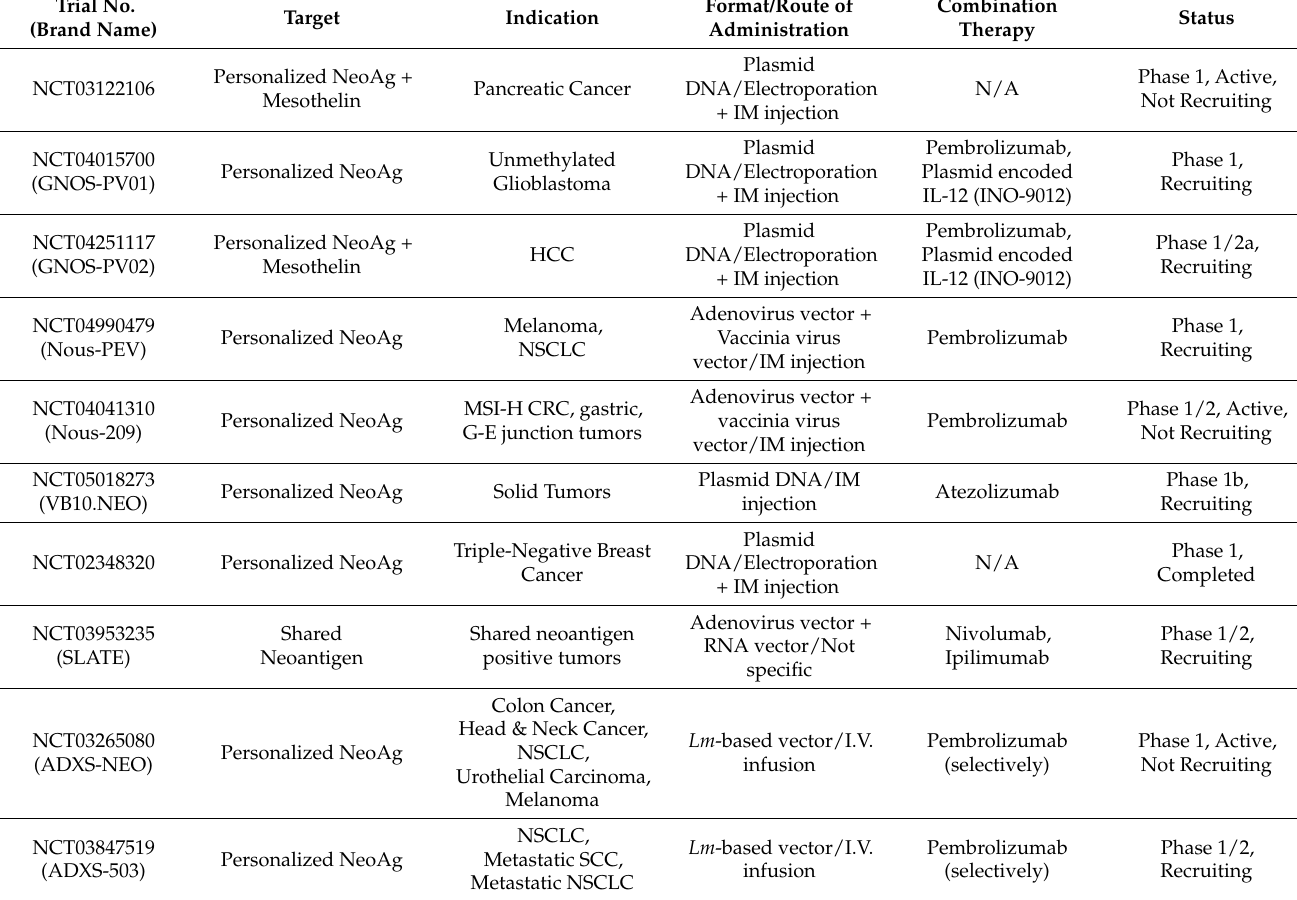
Table 2. Clinical trials of neoantigen-DNA